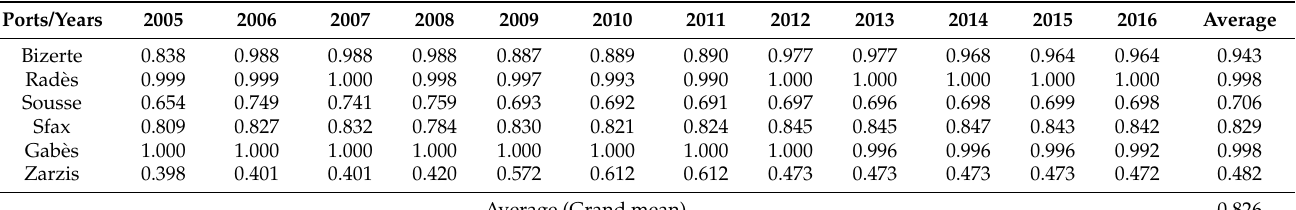
Table 6. Scale efficiency scores for the Tunisian ports (2005–2016).